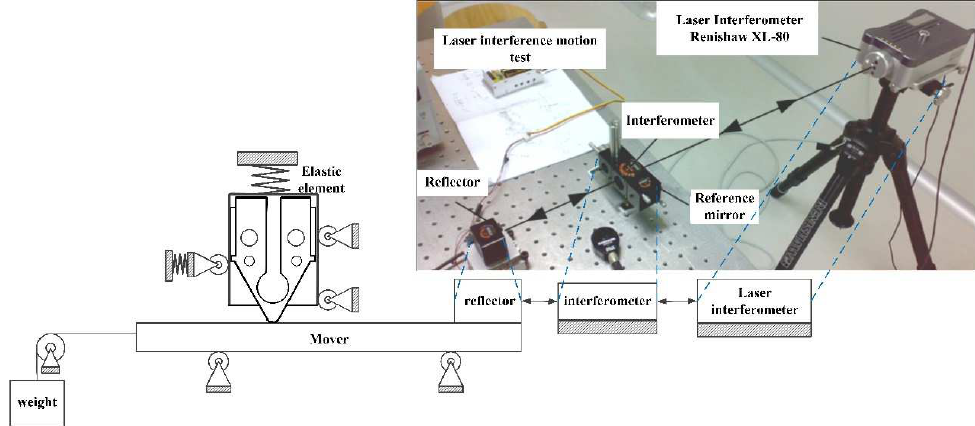
Figure 15. Output characteristic test system and laser interference motion test system.